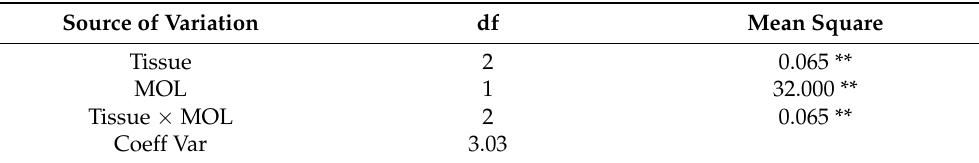
Table 4. Two-way ANOVA analysis for expression of myogenin in Kermani lambs in different tissues at different levels of MOL feeding.